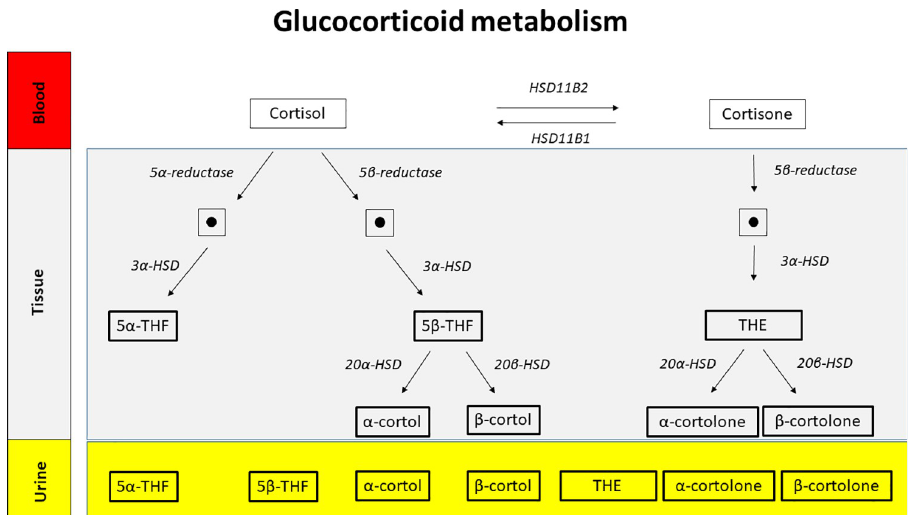
Fig 2. Glucocorticoid metabolism. Glucocorticoid metabolites in blood, tissue and urine of humans. Bulky framed urinary steroid hormone metabolites were measured in urine by GC-MS and found to be increased in diabetic patients as compared to a healthy control group. Many more glucocorticoid metabolites exist. For convenience, only the metabolites discussed in this paper are shown. The dots stand for intermediates that are not discussed in the manuscript. � p < 0.05, �� p < 0.01, ��� p < 0.0001, ns = not